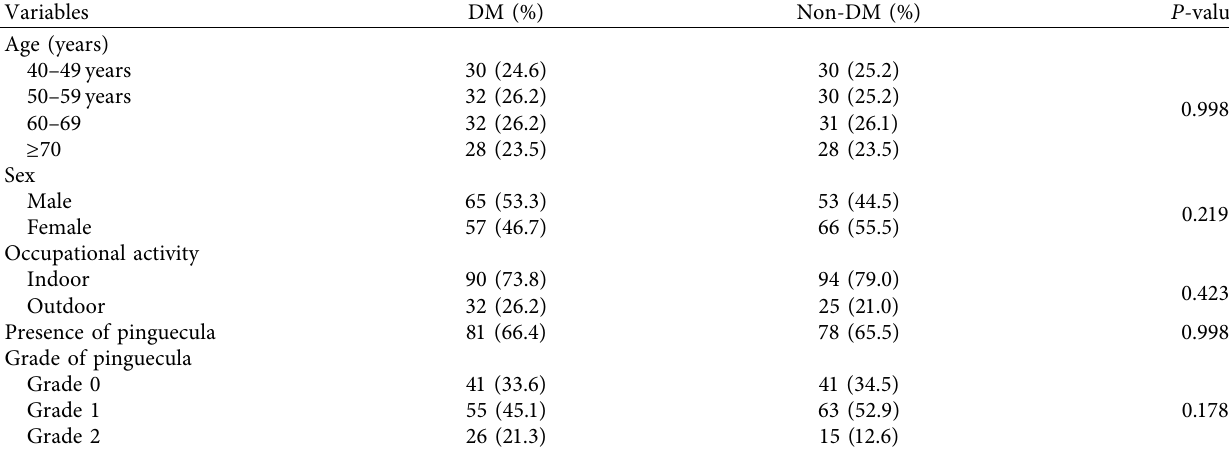
Table 2: Patients’ characteristics and variables in diabetic vs. nondiabetic groups.